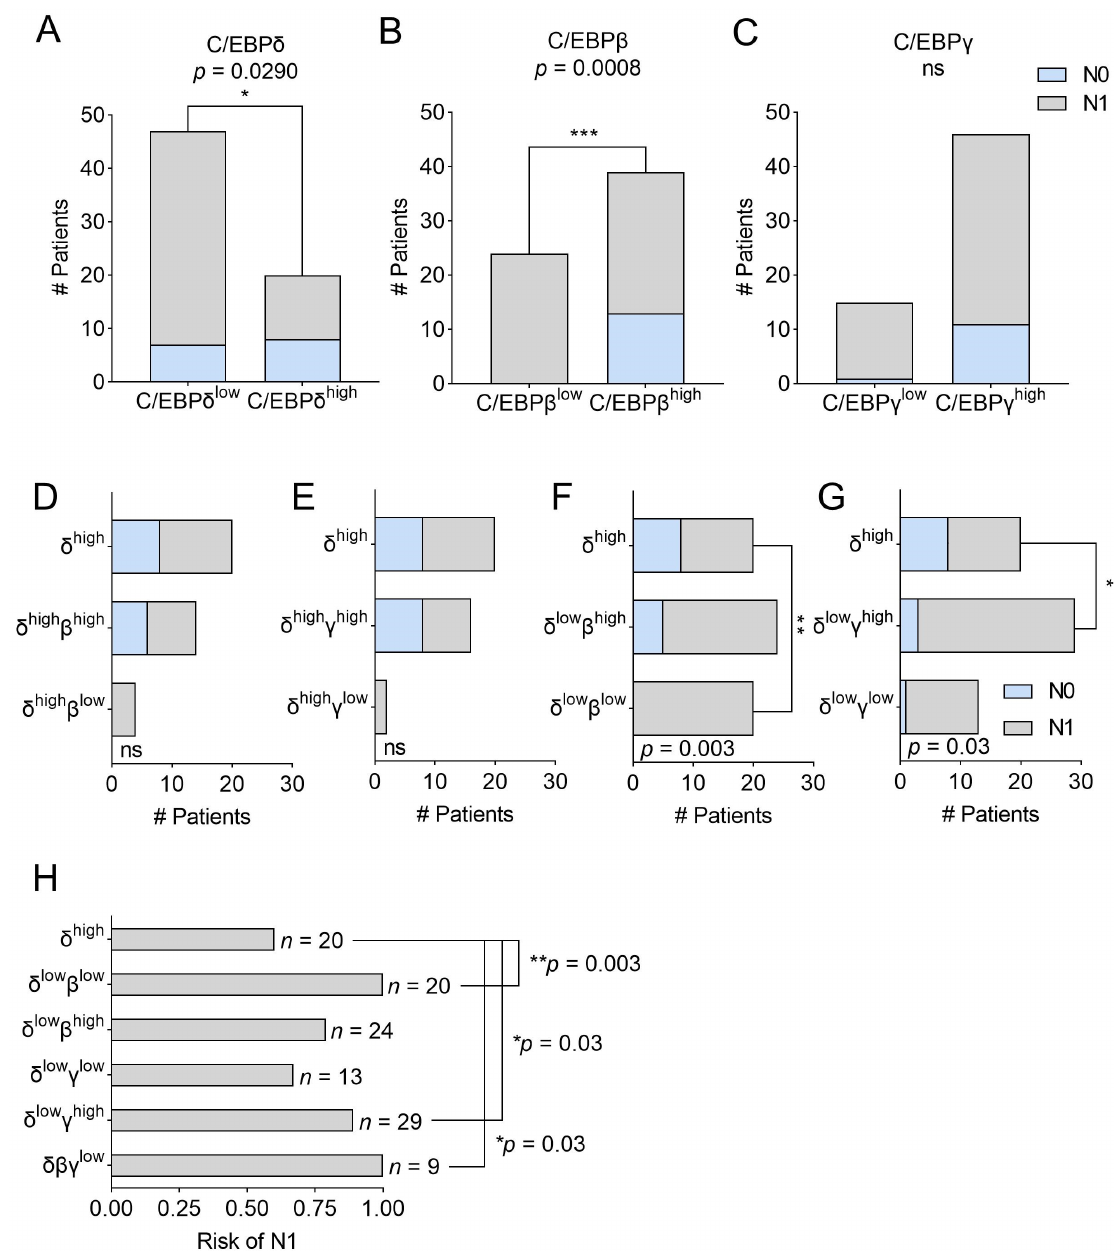
Figure 4. Bar graphs representing contingency tables of C/EBP-expression and lymph node involvement. Panels ( A – C ) Plotted are the number of patients experiencing no lymph node involvement (light blue) or lymph node involvement (gray) dichotomized by ( A ) C/EBP δ , ( B ) C/EBP β or ( C ) C/EBP γ protein expression. Panels ( D – G ) show the same groups as Figure 3D–G, i.e., bar graphs of contingency tables of patients with high C/EBP δ (top bar) as well as patients with ( D ) high C/EBP δ with high C/EBP β and high C/EBP δ with low C/EBP β , ( E ) high C/EBP δ with high C/EBP γ and high C/EBP δ with low C/EBP γ , ( F ) low C/EBP δ with high C/EBP β and low C/EBP δ with low C/EBP β , ( G ) low C/EBP δ with high C/EBP γ and low C/EBP δ with low C/EBP γ . Stainings for C/EBP β or C/EBP γ were not available for all patients in the C/EBP δ high group, resulting in slightly different patient numbers among the groups. ( H ) Plotted is the risk of experiencing lymph node involvement per patient group and the number of patients per group ( n ). p -values are derived from Fisher’s exact tests. ns = not significant, * p < 0.05, ** p < 0.01, and *** p < 0.001.